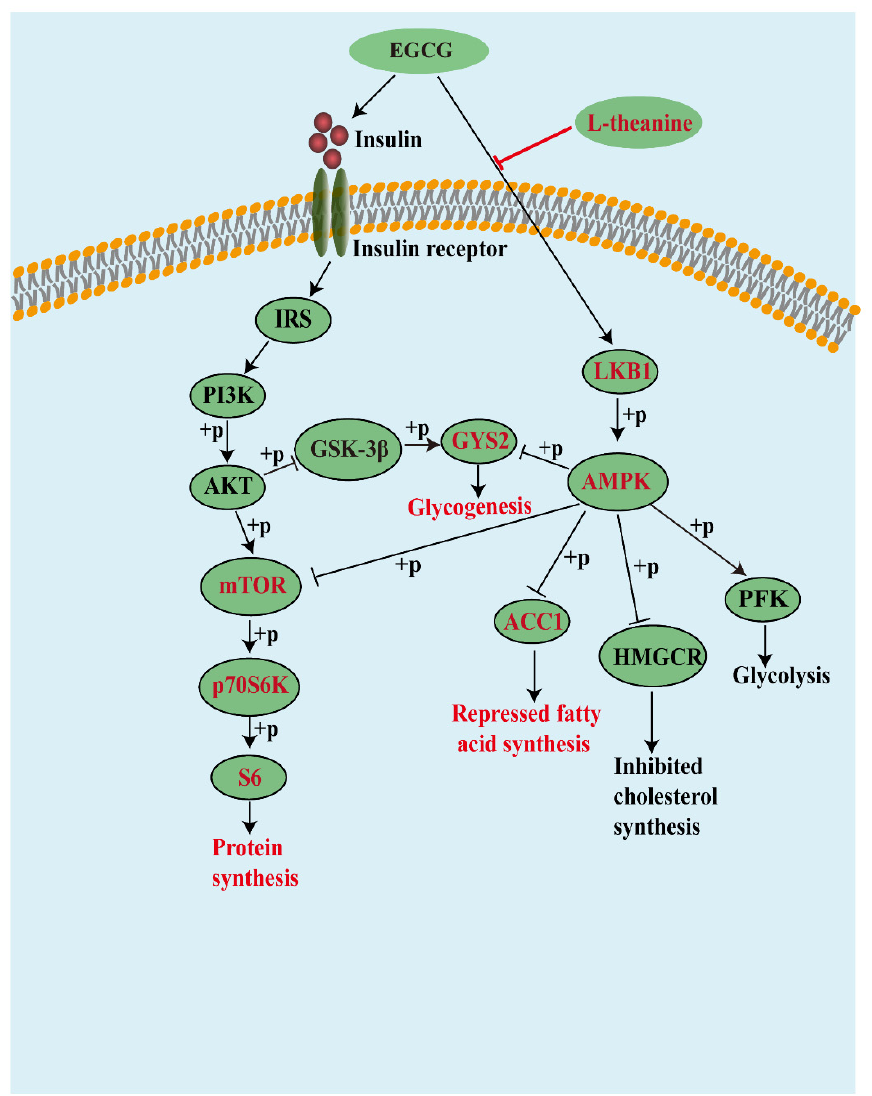
Figure 6. Schematic diagram of the